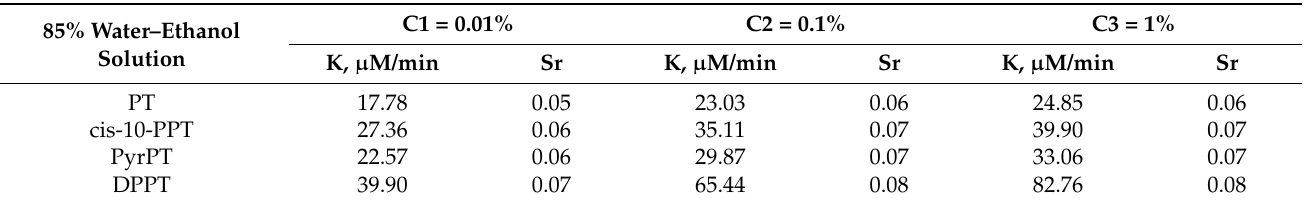
Table 6. Values of the antioxidant activity of phenothiazine and its derivatives in 85% water– ethanol